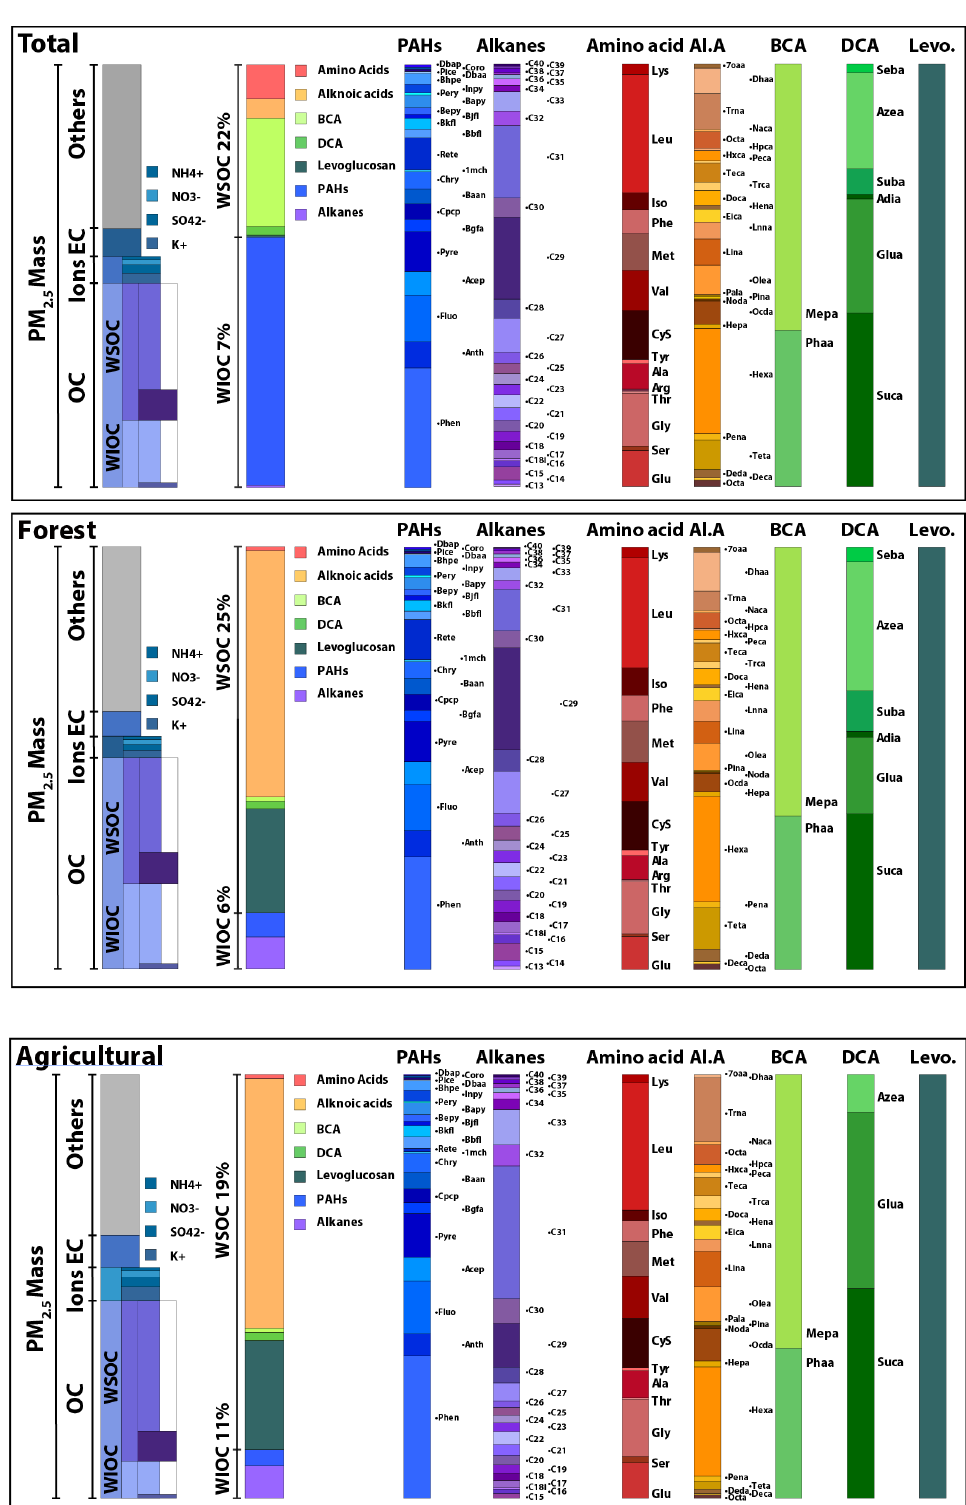
Figure 3. Composition ratio of PM 2.5 mass by biomass burning of woods and agricultural byproducts.